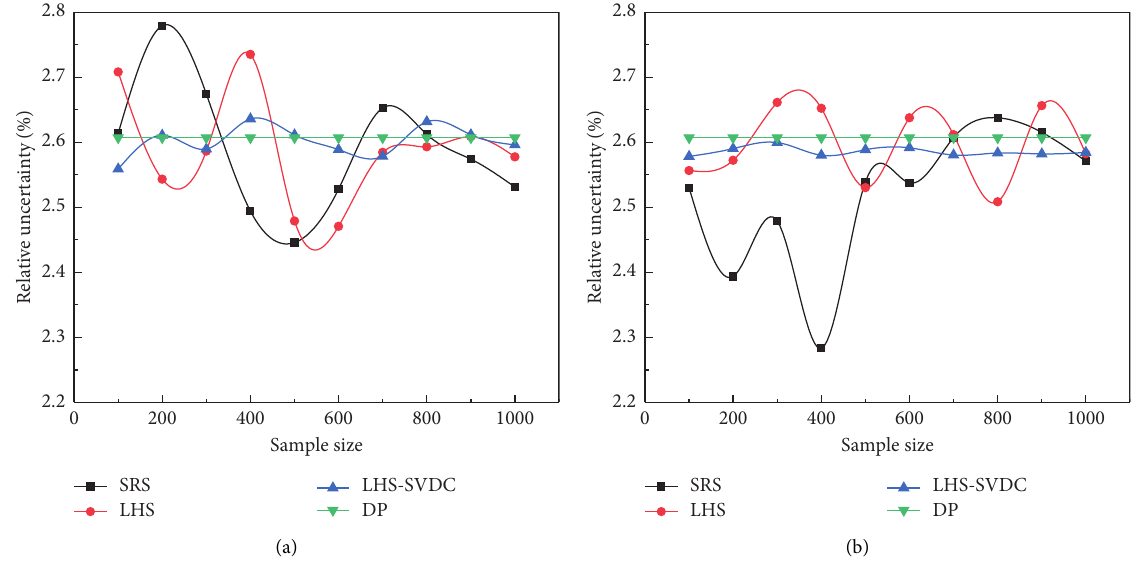
Figure 14: The relative uncertainty of the maximum fuel temperature propagated from the uncertainty samples generated by different sampling methods. (a) Inputs with uniform distribution. (b) Inputs with normal